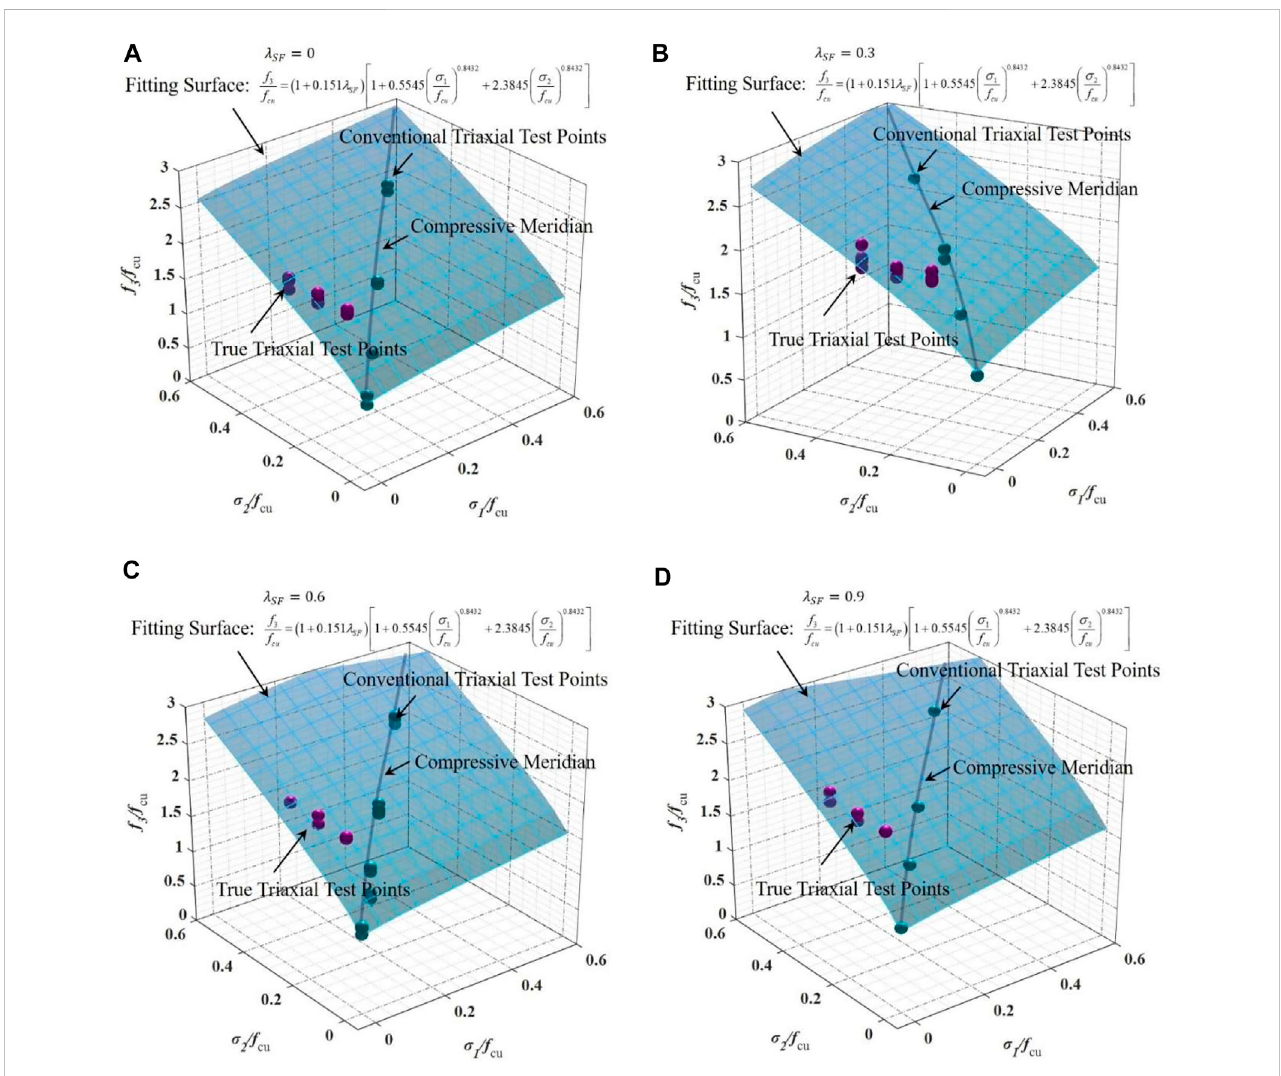
FIGURE 10 Fitting result diagram: (A) λ SF (cid:1) 0, (B) λ SF (cid:1) 0 . 3, (C) λ SF (cid:1) 0 . 6, and (D) λ SF (cid:1) 0 .